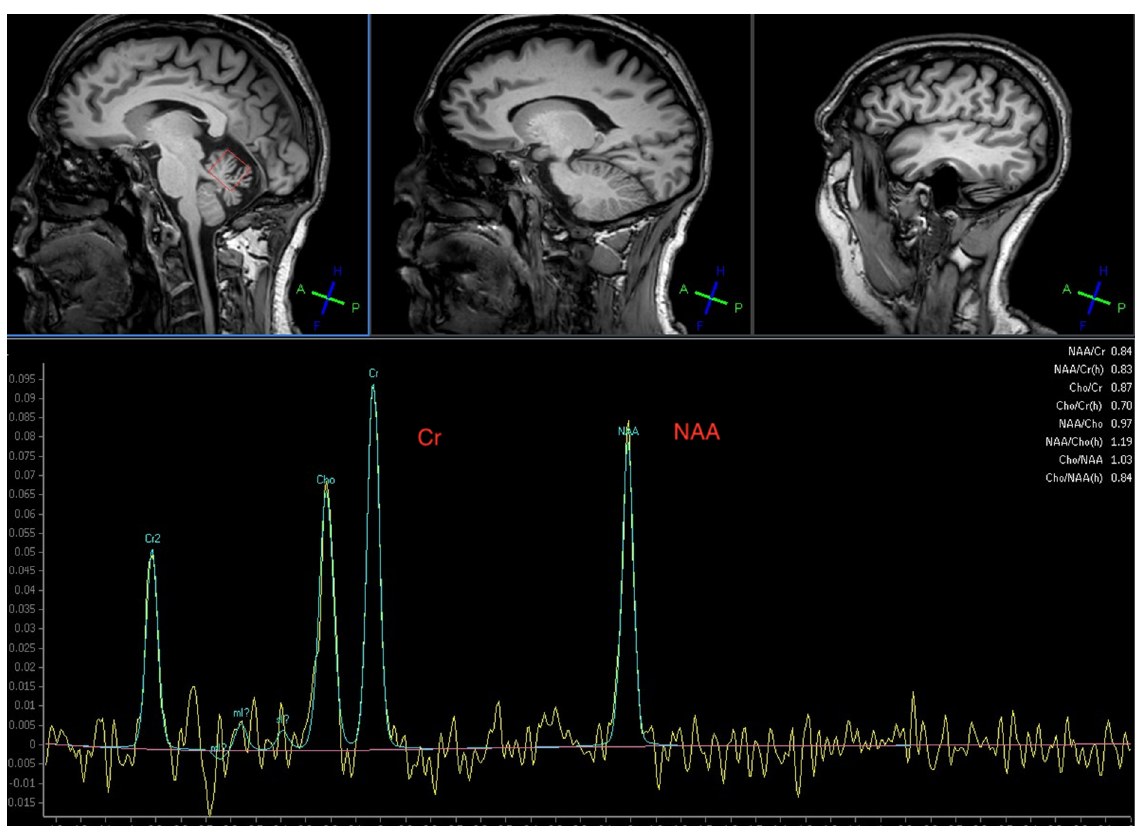
Figure 1. Magnetic Resonance Spectroscopy of the cerebellar vermis from the illustrative clinical case (see text) showing a significant reduction of the N-Acetyl-Aspartate to Creatine ratio (NAA/Cr) at 0.84 (normal should be above 1). All but one of these patients with stiff person syndrome (SPS) had abnormal spectroscopy of the cerebellum highlighting the fact that cerebellar involvement is universal in SPS.